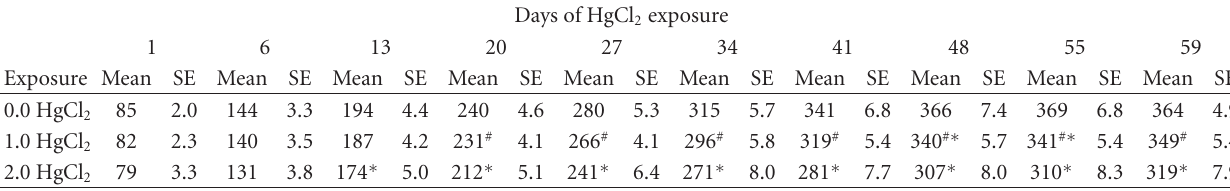
Table 1: Mean weights of subjects across exposure